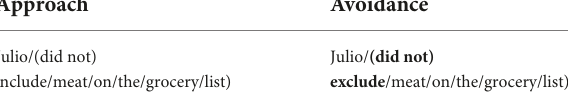
TABLE 1 Example of approach and avoidance sentences in affirmative and negative versions.